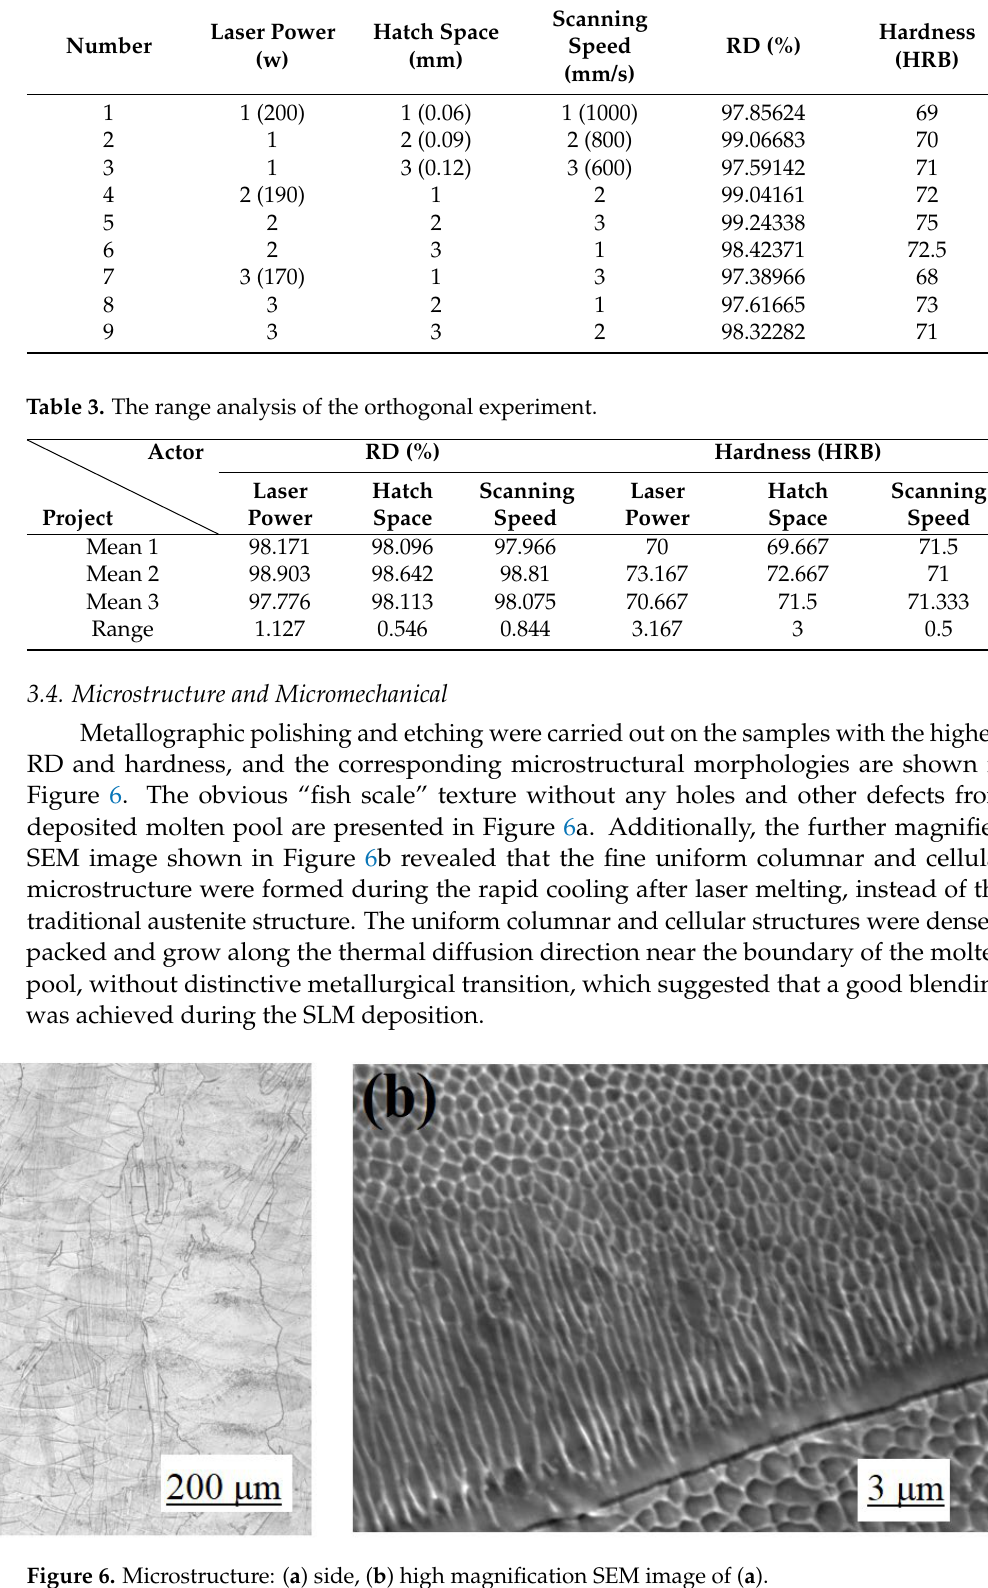
Figure 6. Microstructure: ( a ) side, ( b ) high magnification SEM image of ( a ). Figure 7a shows the grain alignment in the side of the as-built sample from the backscattered electron (BSE) signal, although the edge of the molten pool was